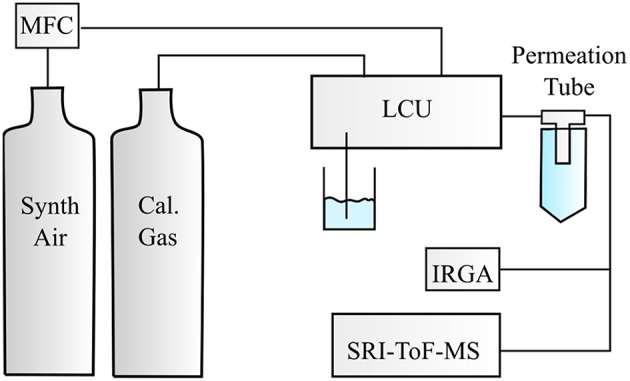
Illustration of the experimental setup. Calibration compounds were either taken from the calibration gas standards or from the diffusion source, which was flushed with a constant synthetic air flow controlled by a mass flow controller (MFC). Different humidity steps were adjusted with the Liquid Calibration Unit (LCU) and monitored by an infrared gas analyzer (IRGA). The humidified synthetic air containing the respective calibration compound(s) was introduced to a selective reagent ion time of flight mass spectrometer (SRI-ToF-MS).